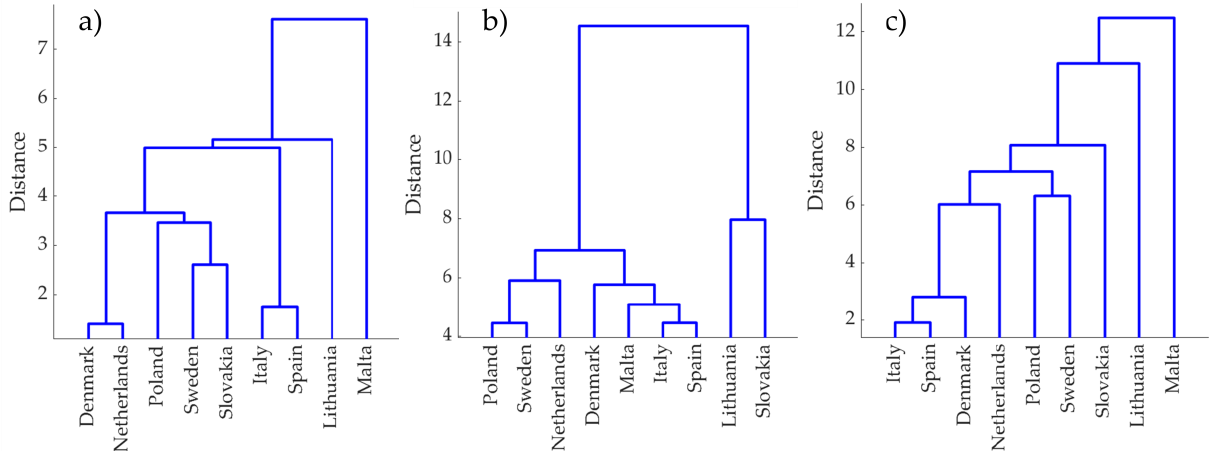
Figure 2. Hierarchical cluster analysis dendrograms according to evaluated TPC, TFC and RSA: ( a ) before fermentation, ( b ) after spontaneous fermentation, ( c ) after bacterial